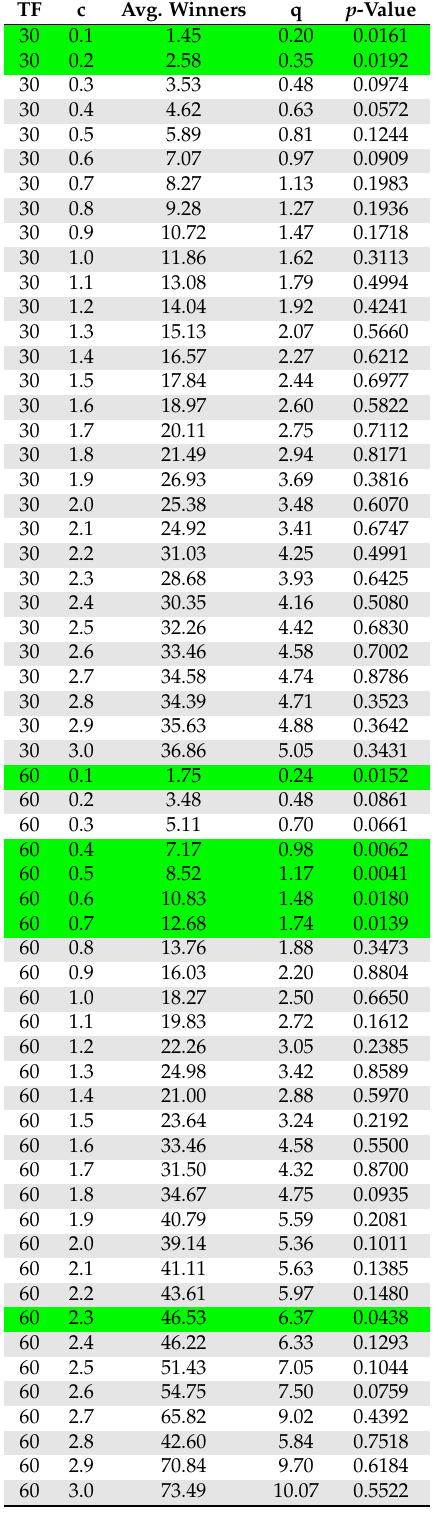
Table 8. Coefficient c and respective p -values for timeframes of 30 and 60 min. Those strategies which present p -values lower than 0.05 have been